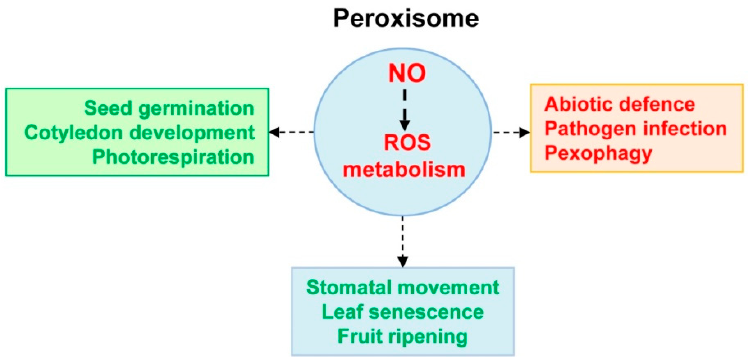
Figure 5. Working model for the implication of the peroxisomal NO/ROS metabolism in physio- logical and stressful plant processes. Based on the available information, it is suggested that NO throughout its derived PTMs ( S -nitrosation and tyrosine nitration) can modulate ROS metabolism. Thus, some antioxidant enzymes can undergo either S -nitrosation or nitration affecting their activity and, consequently, modulating the content of molecules such as NO, O 2 • – or H 2 O 2 . Therefore, the relevance of these NO-derived PTMs could be different according to the distinct physiological or stressful processes where the levels of NO and ROS could be significantly affected.